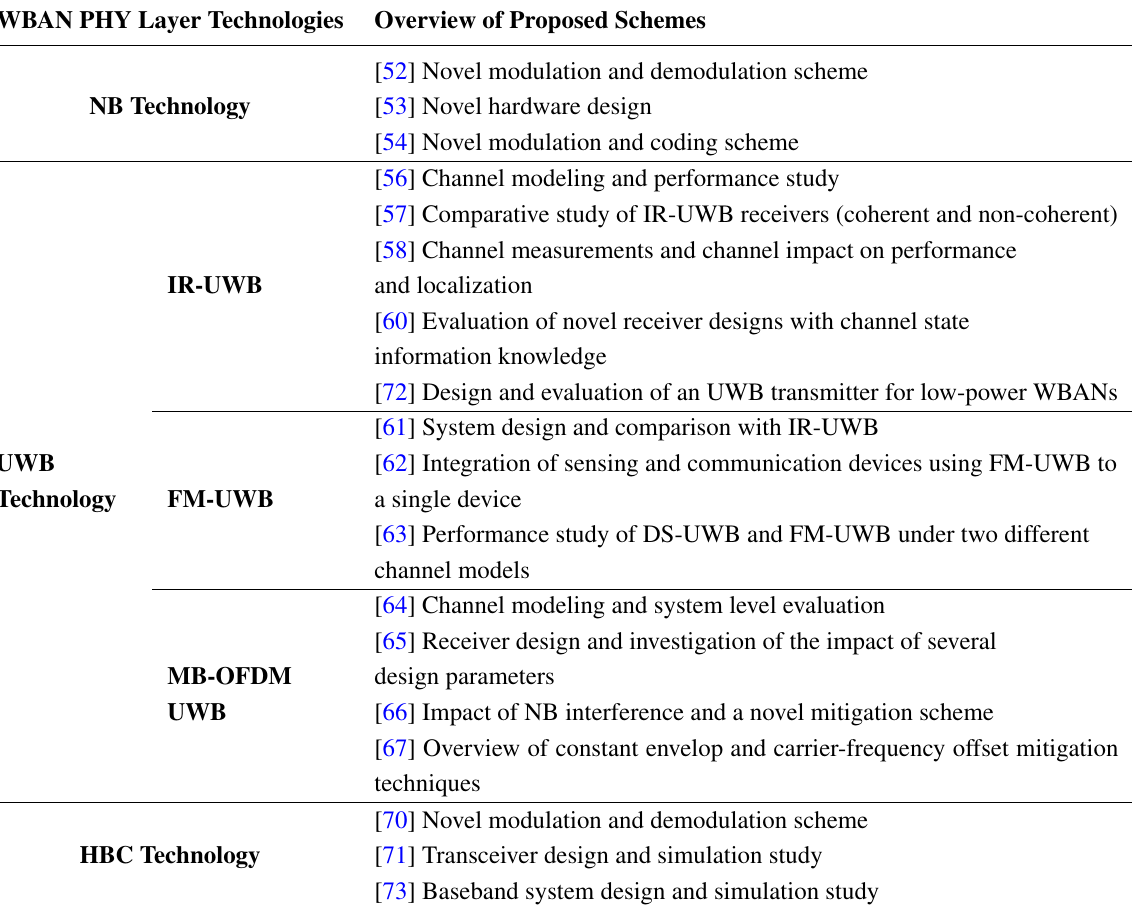
Table 3. Overview of physical (PHY) layer transmission technologies